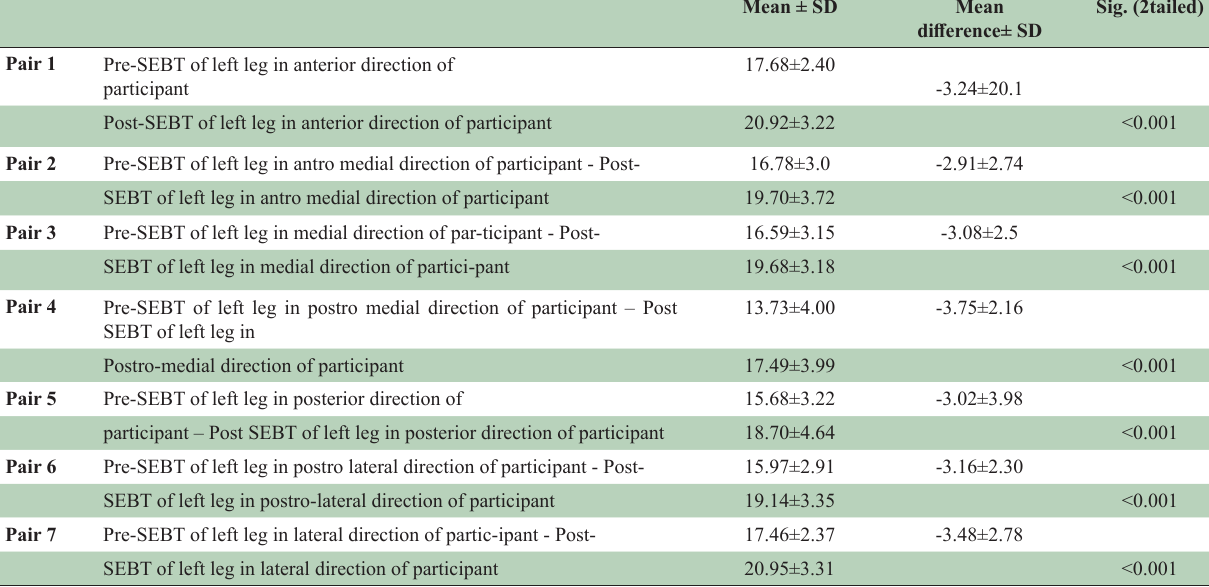
Wobble board exercises and dynamic balance Table-III: Pre and Post SEBT findings of Left Leg using Paired Sample